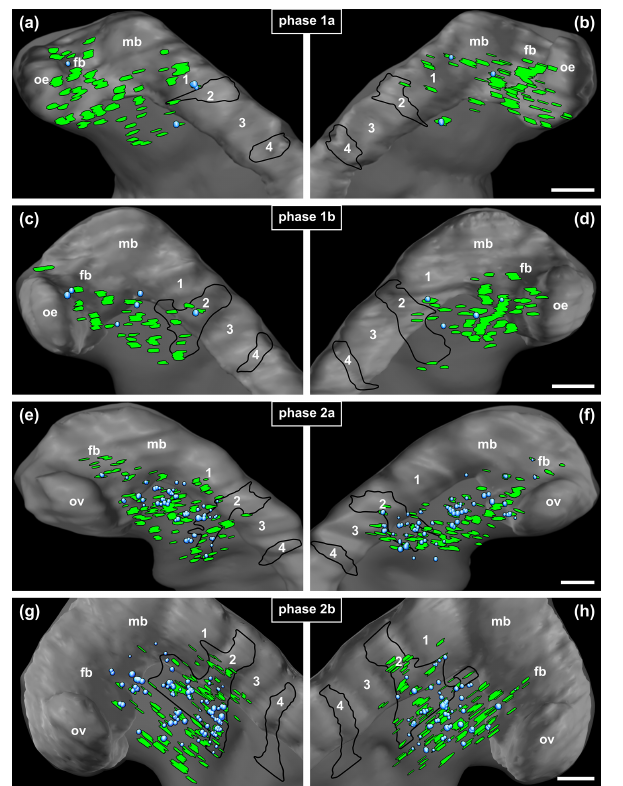
Figure 21. Apoptosis and delamination of neuroblasts in the trigeminal placode of Tupaia belangeri . 3-D reconstructions of em- bryonic heads from phases 3 to 5 of ocular development (left sides of the bodies: a , c , e , g ; right sides: b , d , f , h ) show apoptotic cells (red), delaminating neuroblasts (blue), and focal trigeminal placo- dal thickenings (green) in the surface ectoderm (transparent gray) as well as high-grade ectodermal thickenings (light gray) in the lens (triangle) and olfactory placode (olf), trigeminal ganglion and nerves (black lines, V1, V2, V3), facial nerve (black lines, aster- isks), and pial brain surface (gray). (a, b) In the trigeminal placode, the peak of apoptosis coincides with the peak of neuroblast delam- ination. Simultaneously, a massive “wedge” of apoptotic cells ex- tends ventrally from the ophthalmic trigeminal placode (position indicated by ophthalmic nerve, V1) to the presumed position of the “ventrolateral postoptic placode” postulated in chick embryos by Lee et al. (2003). (c–f) While low numbers of apoptotic cells persist in the regressing trigeminal placode, the apoptotic wedge merges with apoptosis being associated with the lens placode (po- sition indicated by triangle or high-grade thickening). (g, h) Apop- totic cells have vanished from the former position of the trigemi- nal placode. 1–4, rhombomeres 1–4; fb, forebrain; mb, midbrain; ov, optic vesicle. Scale bars = 100µm. Reproduced from Knabe et al. (2009, Fig. 6.) © the authors 2009.